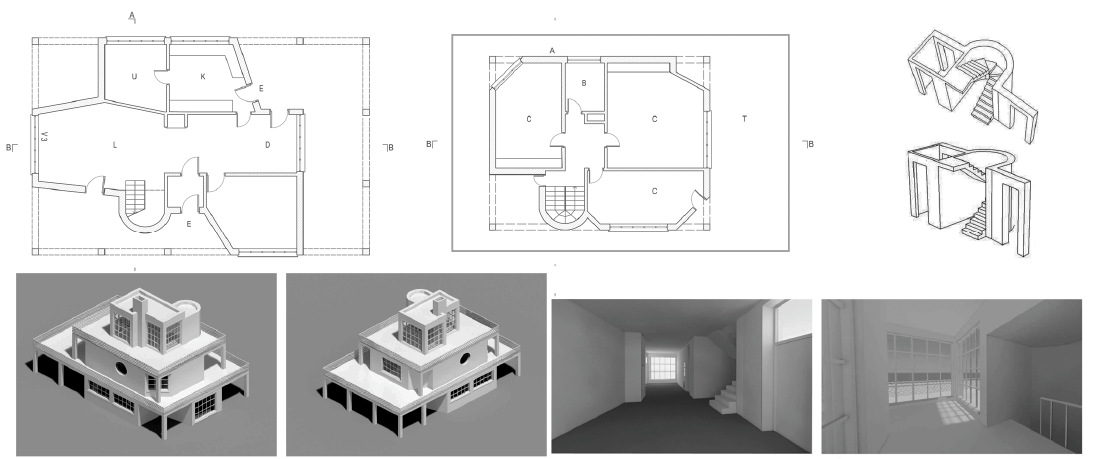
Figure 9. House 3. Plans, schemes, axonometric views, perspectives (C.